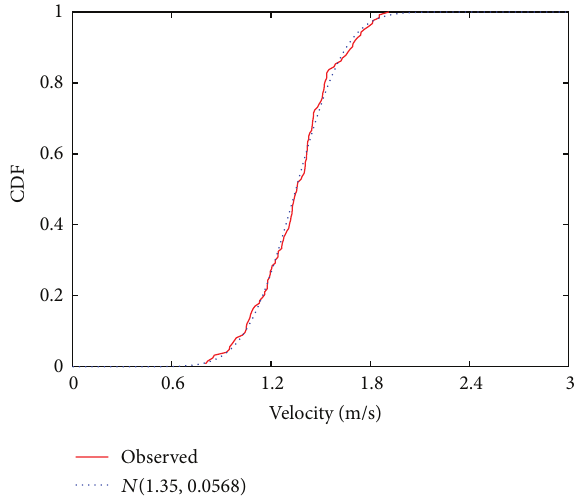
Figure 5: Cumulative distribution function of pedestrian velocities and its approximation with a normal distribution.